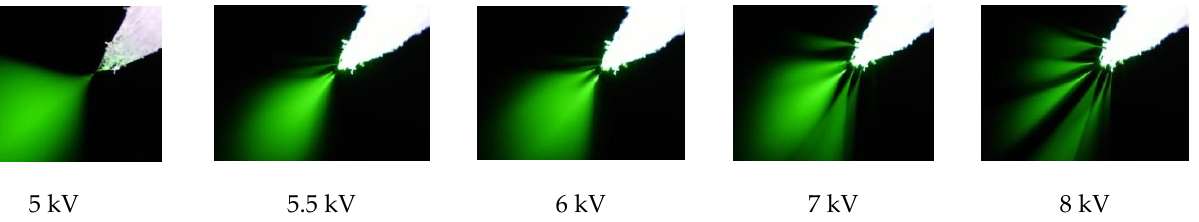
Figure 4. The photos of sharply angled marker tips (conical) in the range of potential 5–8 kV. Multiple Taylor cones formation from sharply angled marker tips.